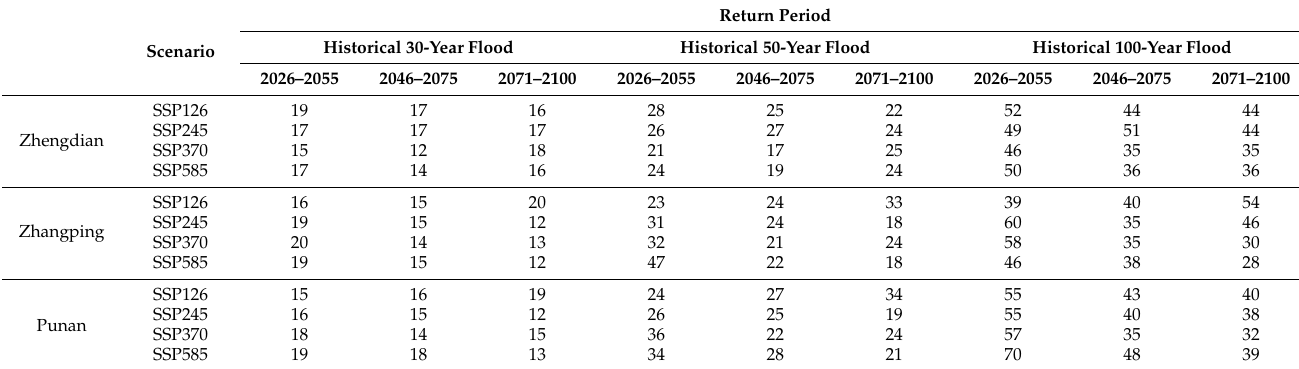
Table 4. Return periods of the historical 30-year, 50-year and 100-year floods occurring in the future at the Zhengdian, Zhangping and Punan stations under the four